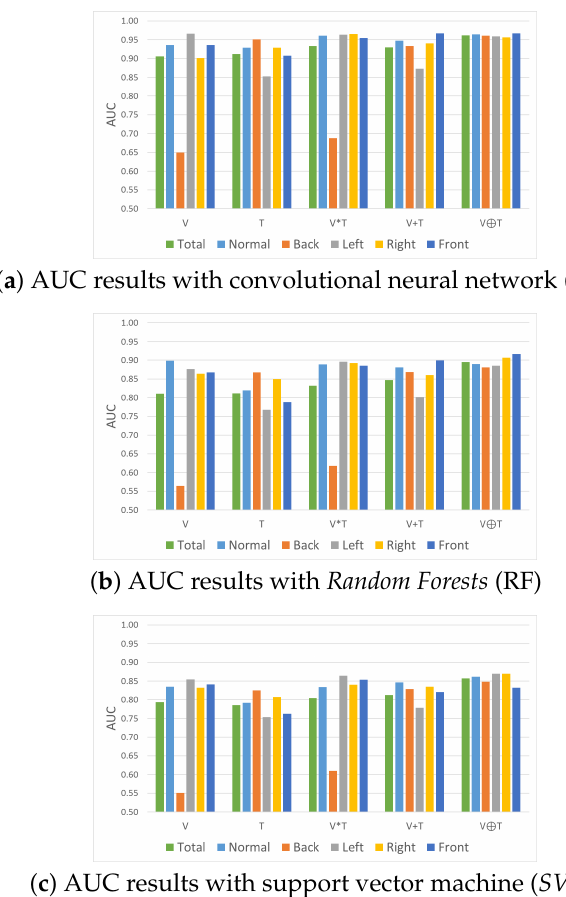
Figure 10. Area under the curve (AUC) comparison in various lighting conditions using ( a ) CNN